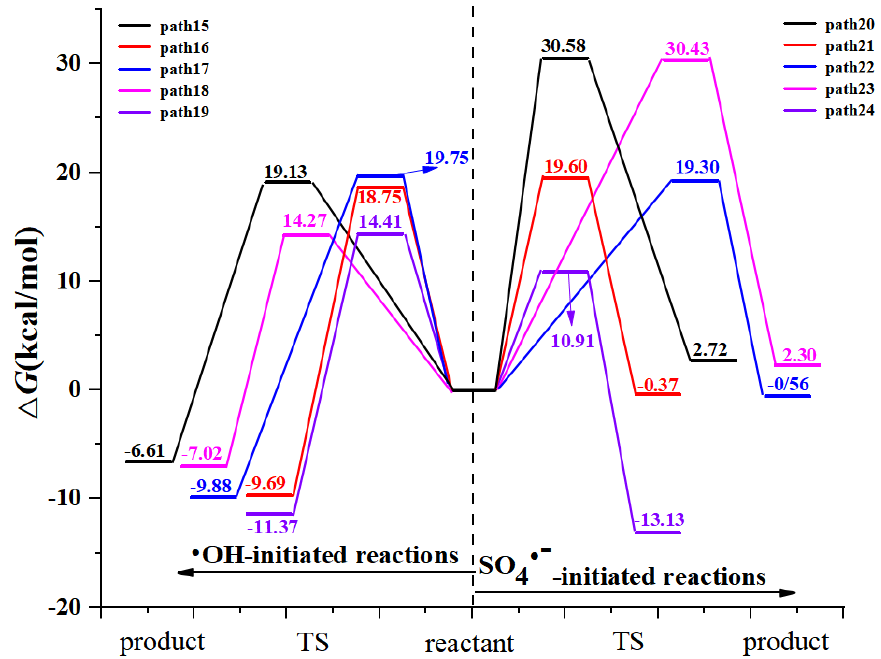
Figure 5. The free energy diagram of FHAT pathways initiated by two radicals in the aqueous phase.